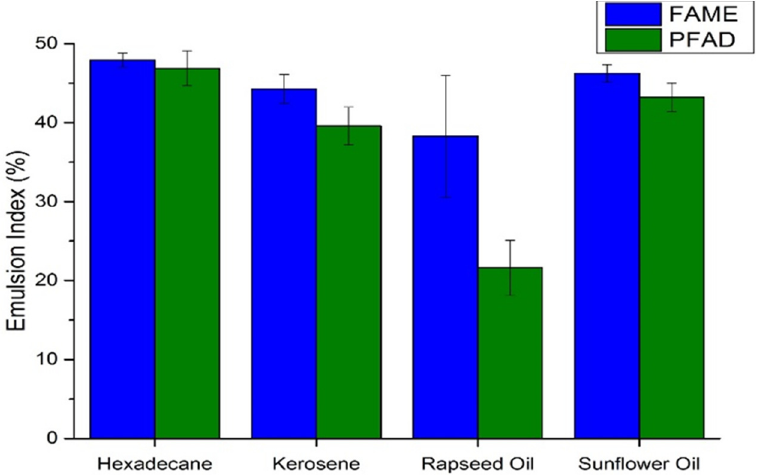
Figure 3. Emulsion Index of rhamnolipids with hexadecane, kerosene, rapeseed oil, and sunflower oil. Table 3 . The effect of rhamnolipid comparison produced from various sources of carbon and microorganisms.